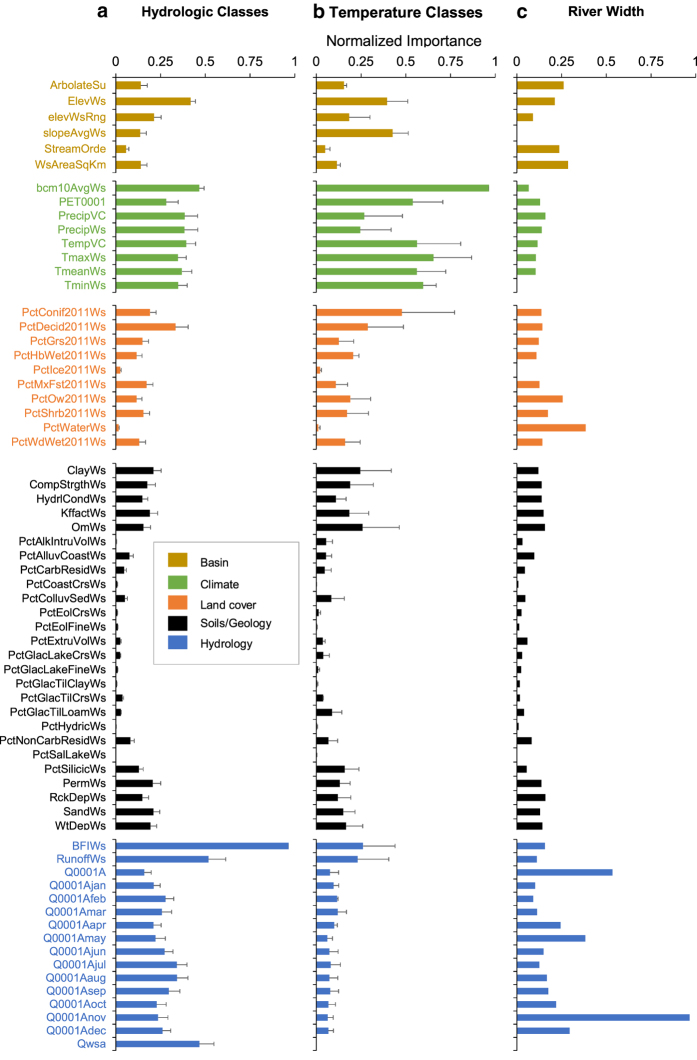
Importance of different predictors used in random forest models.Random forests were used to predict (a) hydrologic classes, (b) temperature classes or average July—August temperature, or (c) river width. Normalized importance refers to node impurity values for the Gini index (classification) or mean-squared error (regression) that are scaled from 0 to 1 using (max – xi)/(max (x) – min(x)). Normalized importance was averaged across all random forest models for hydrologic classes and temperature. Error bars represent 1 SE. Note: only 1 random forest model was developed for river width.